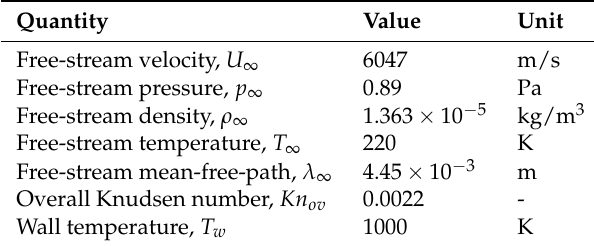
Table 2. Initial conditions for the Mach 20 cylinder.